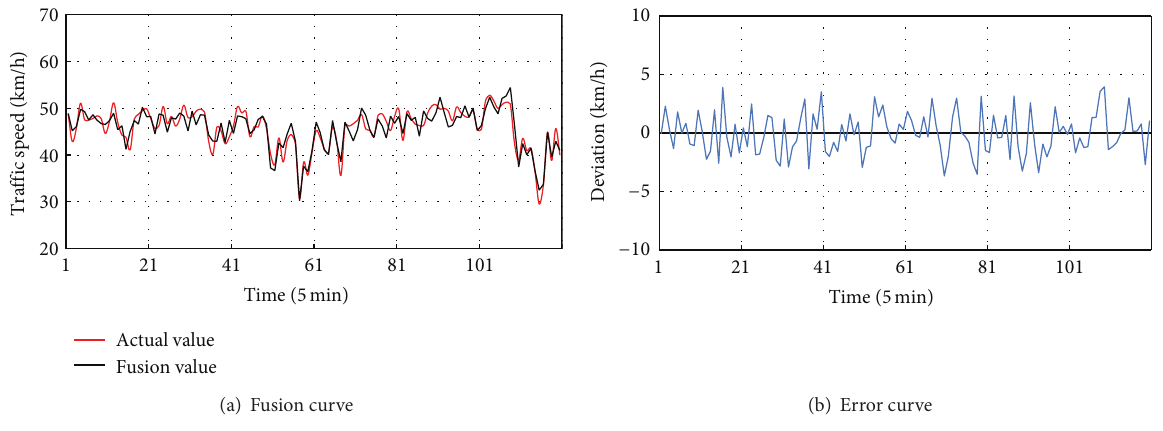
Figure 13: Fusion curve and error curve of space-matching fusion